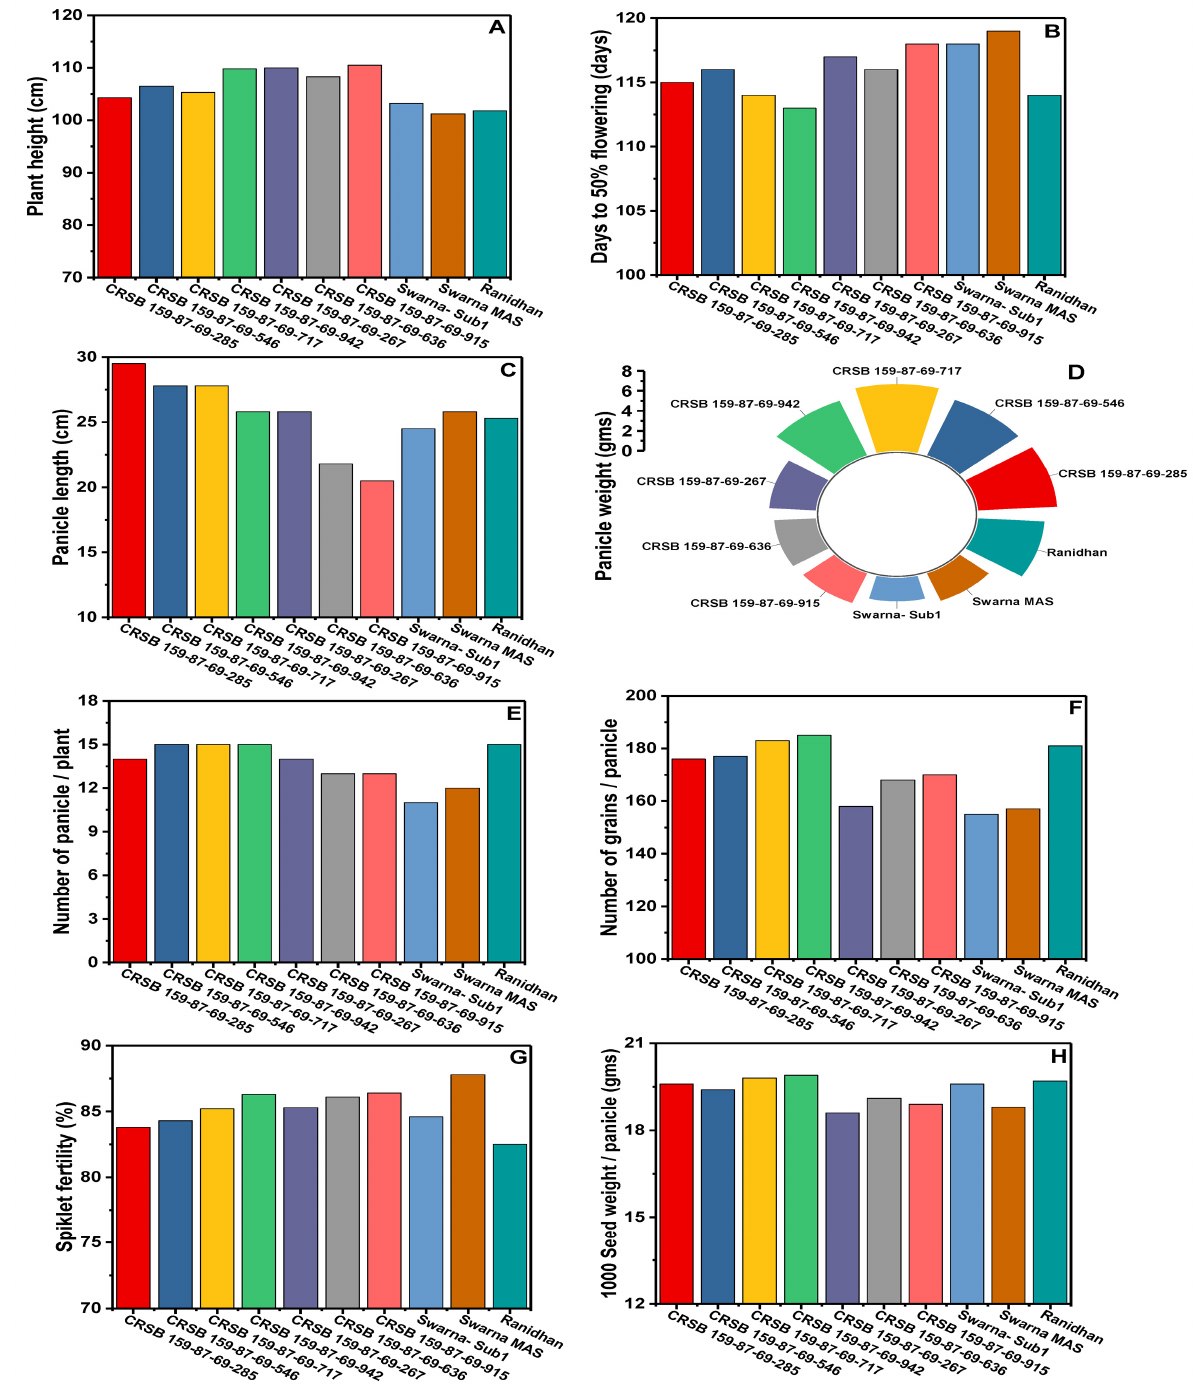
Figure 9. Diagrammatic representation of similarity of the pyramided and parental lines for ( A ) plant height, ( B ) days to 50% flowering, ( C ) panicle length, ( D ) panicle weight (g) ( E ) number of panicles/plant, ( F ) number of grains/panicle, ( G ) spikelet fertility, and ( H ) 1000-seed weight.